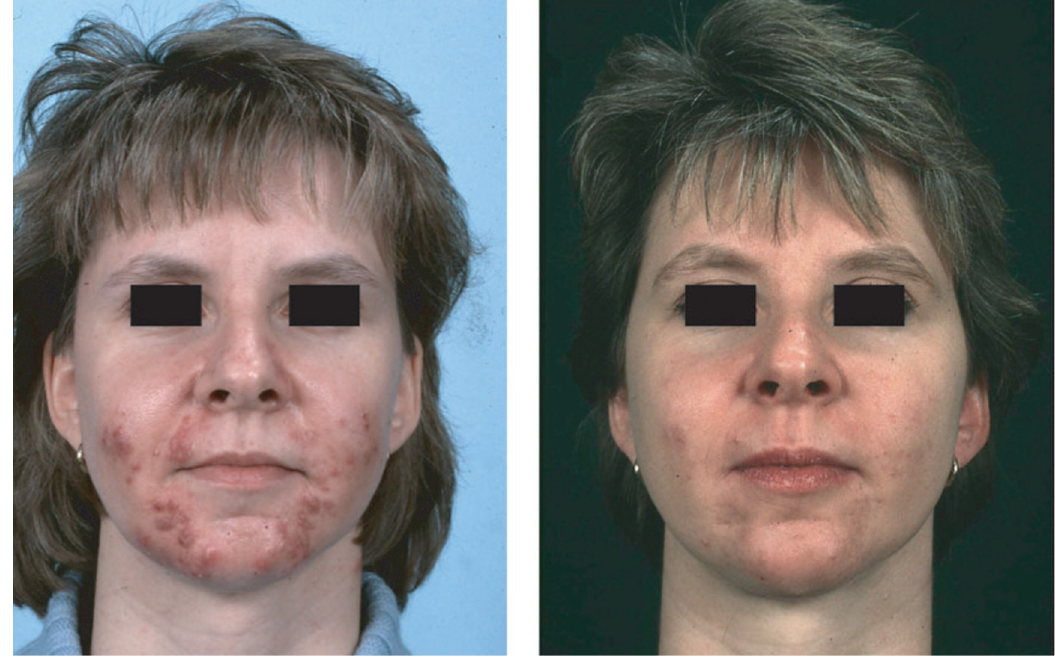
Figure 1. NCAH recalcitrant to hormonal antiandrogens and systemic isotretinoin—in a 31-year-old woman before ( left ) and after ( right ) 2 months of treatment with prednisolone 5 mg/d. Reproduced from Zouboulis and Piquero-Martin [98] with permission from S. Karger AG, Basel.